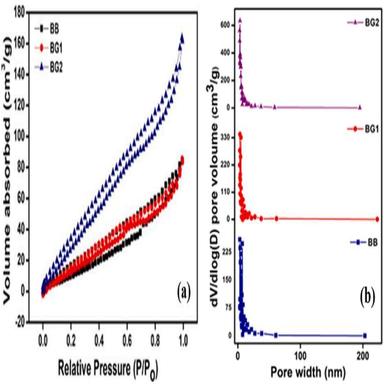
(a) BET surface area and (b) BJH pore size distribution plot of bare BB, BG1 and BG2 nanocomposites.